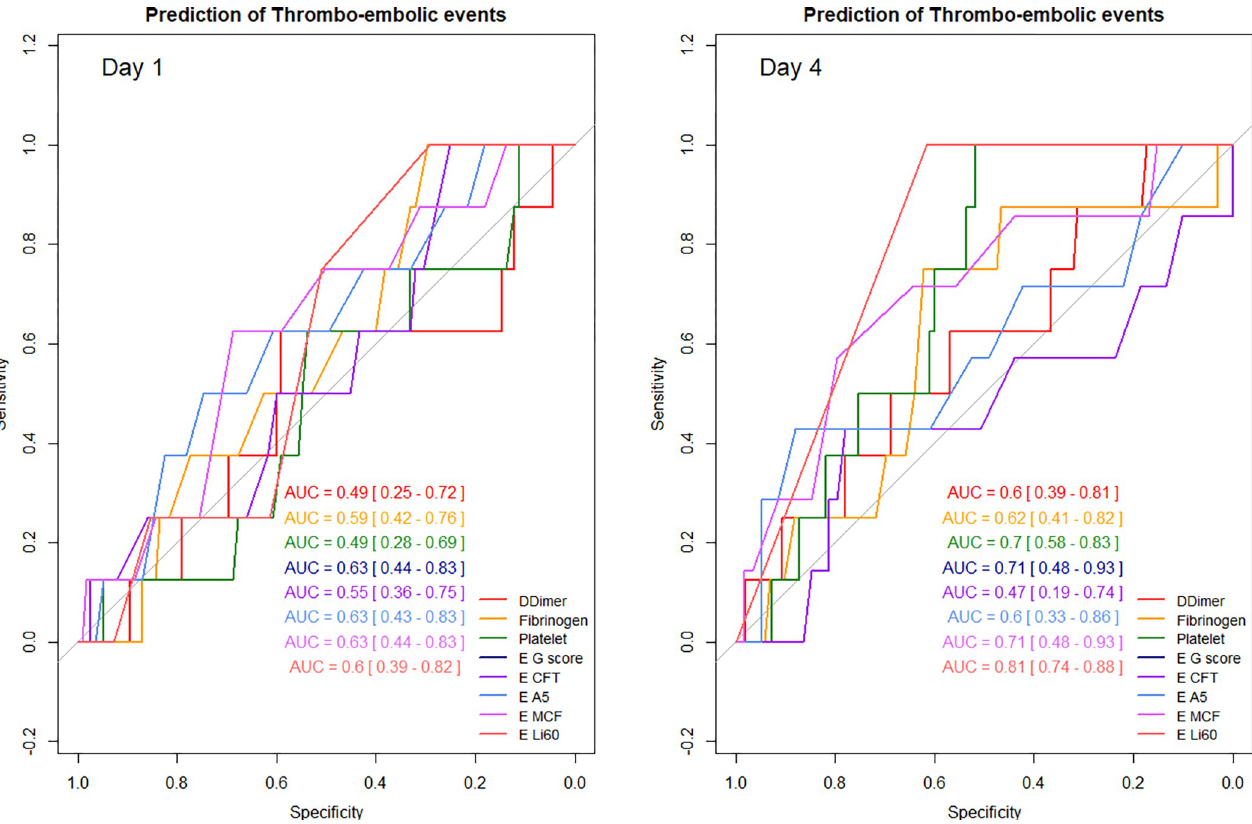
Fig 3. Prediction of the occurrence of thrombo-embolic events during ICU stay by coagulation indices on day 1 and day 4. AUC: Area Under the Curve; E: EXTEM; CFT: Clot formation time; A5: Clot amplitude 5 minutes after CT; MCF: Maximum clot firmness; Li60: Lysis index at 60 minutes.